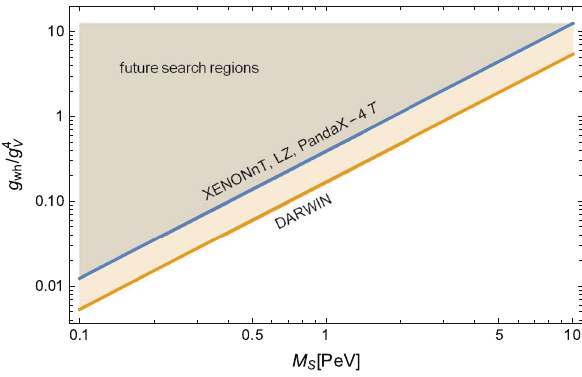
Fig. 6 The skyrmion-nucleon recoil cross section for 100TeV ≤ μ